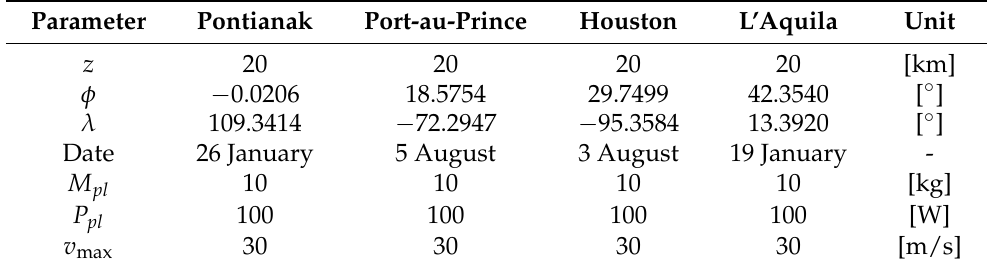
Table 6. Mission design specifications for operations in the considered case